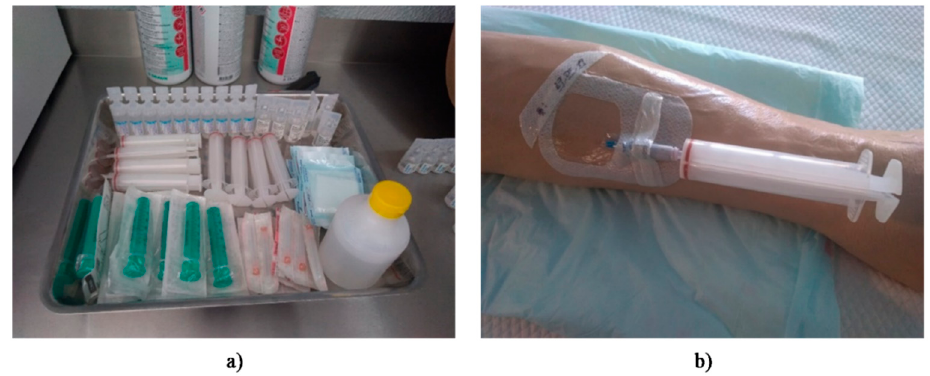
Figure 2. Simulation environment in nursing laboratory for usability tests, with ( a ) the material